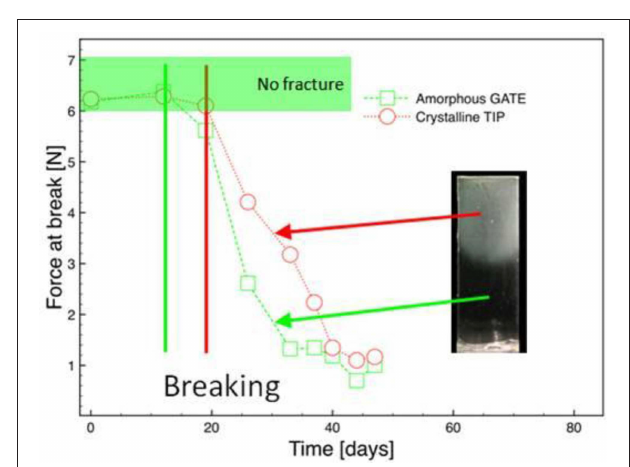
FIGURE 13 | Evolution of force at break during hydrolysis of micro-injected biphasic PLA sample (amorphous tip, crystalline